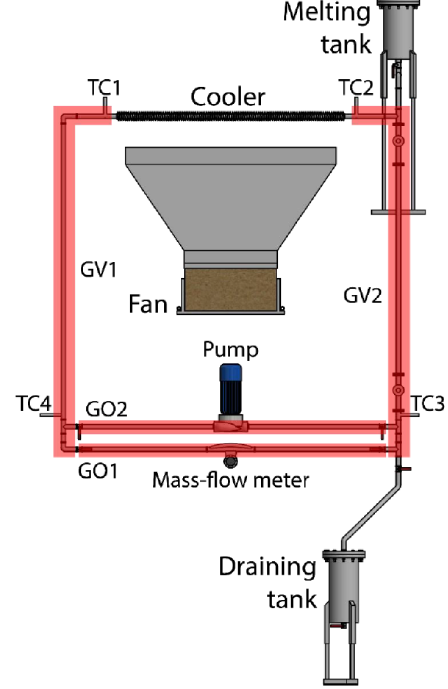
Fig. 3. Heating and instrumentation in DYNASTY